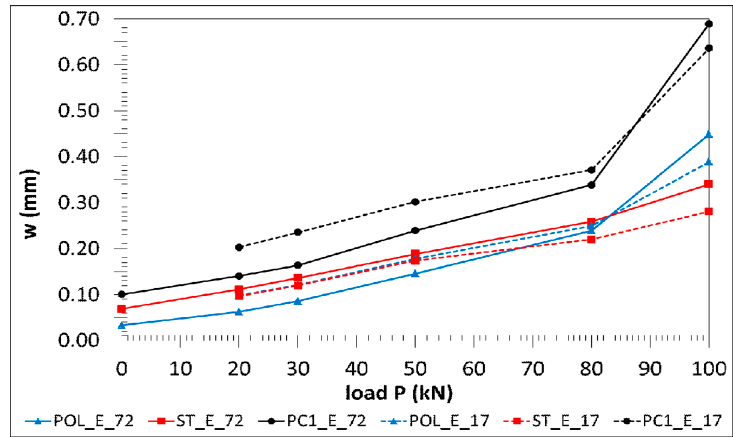
Figure 5. Mean crack width in the constant moment region—Set #2 and #3.